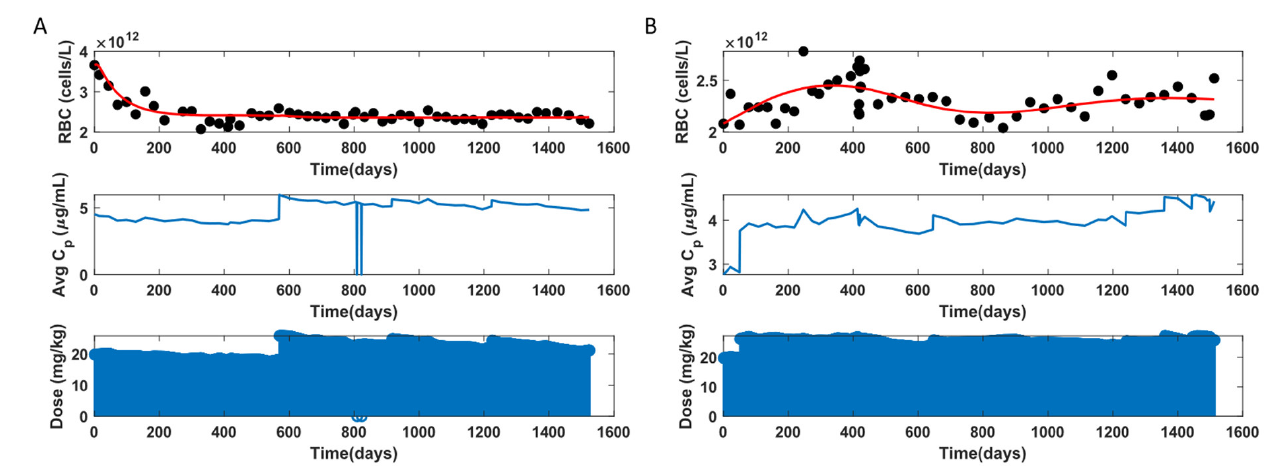
Figure 13. RBC model fit to data for two representative participants. ( A ): with myelosuppression, ( B ): without myelosuppression.